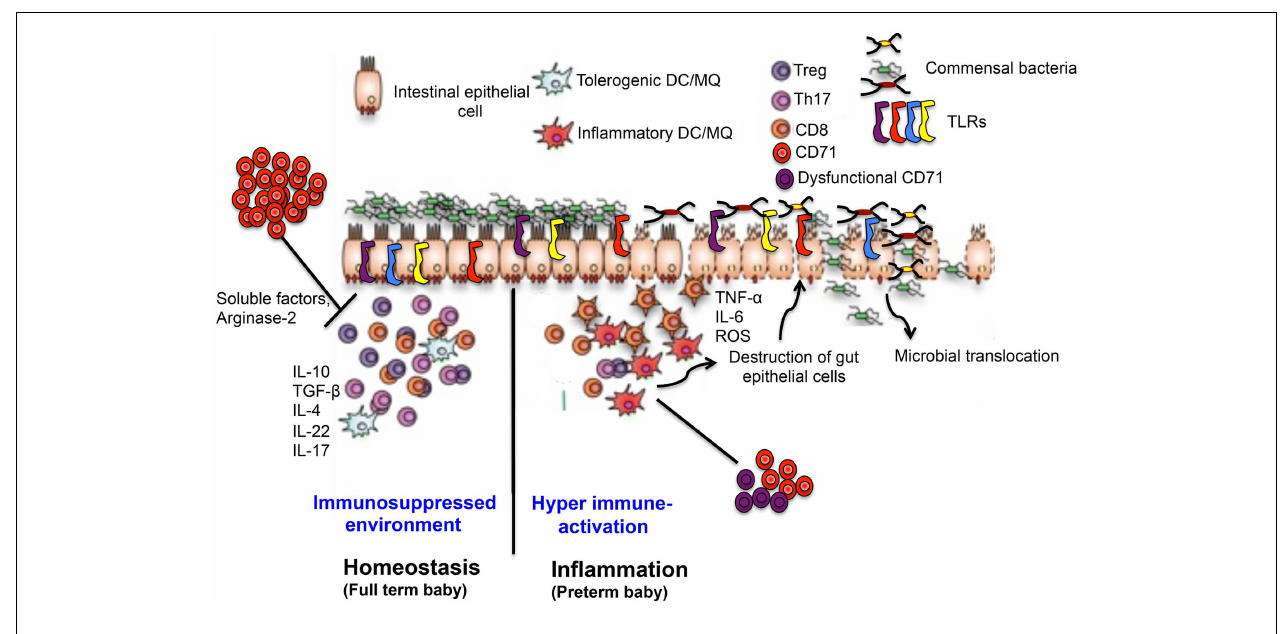
integrity. In contrast, lower and/or dysfunctional CD71 + erythroid cells in preterm disrupts normal immune homeostasis in the gut leading to a switch from a suppressed environment to a pro-inflammatory state, up-regulatesTLR expression, dysbiosis, and pathological alterations associated with